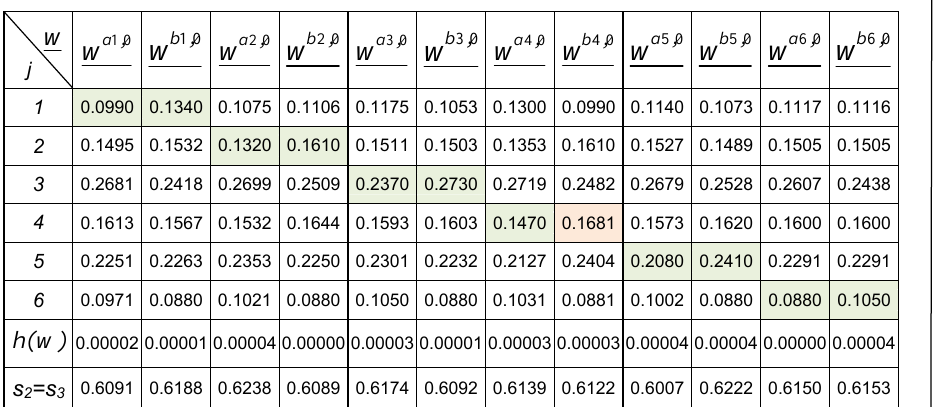
Table 4 – System of basic solutions for the separating hyperplane 0  )w(h Таблица 4 – Система базовых решений для разделения гиперплоскостей 0  )w(h Табела 4 – Систем основних решења за хиперраван